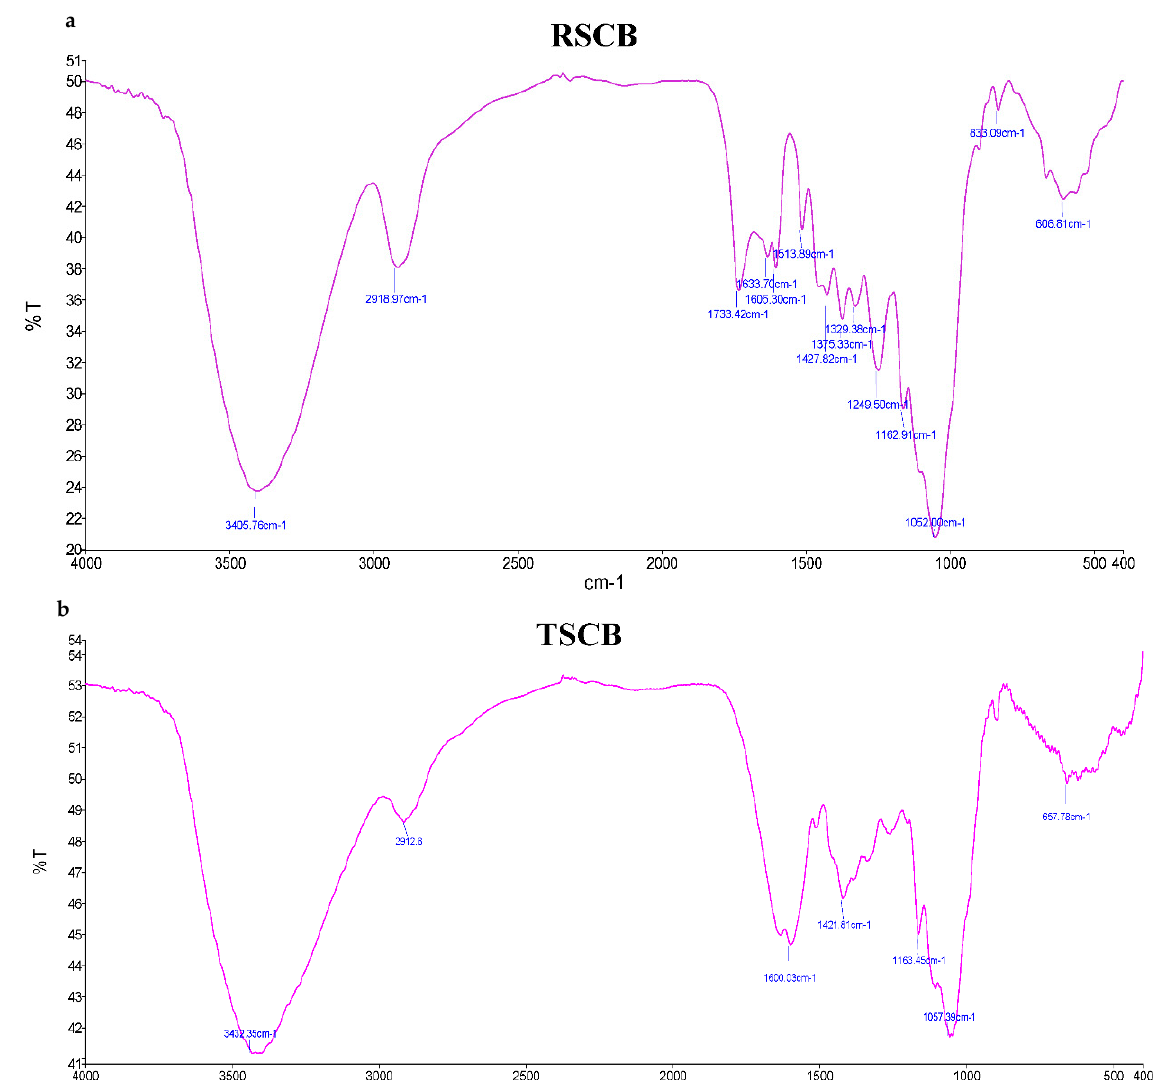
Figure 1. ( a ) FTIR spectrum of RSCB ( b ) FTIR spectrum of treated sugarcane bagasse (TSCB). Table 3. FTIR characteristics of RSCB.